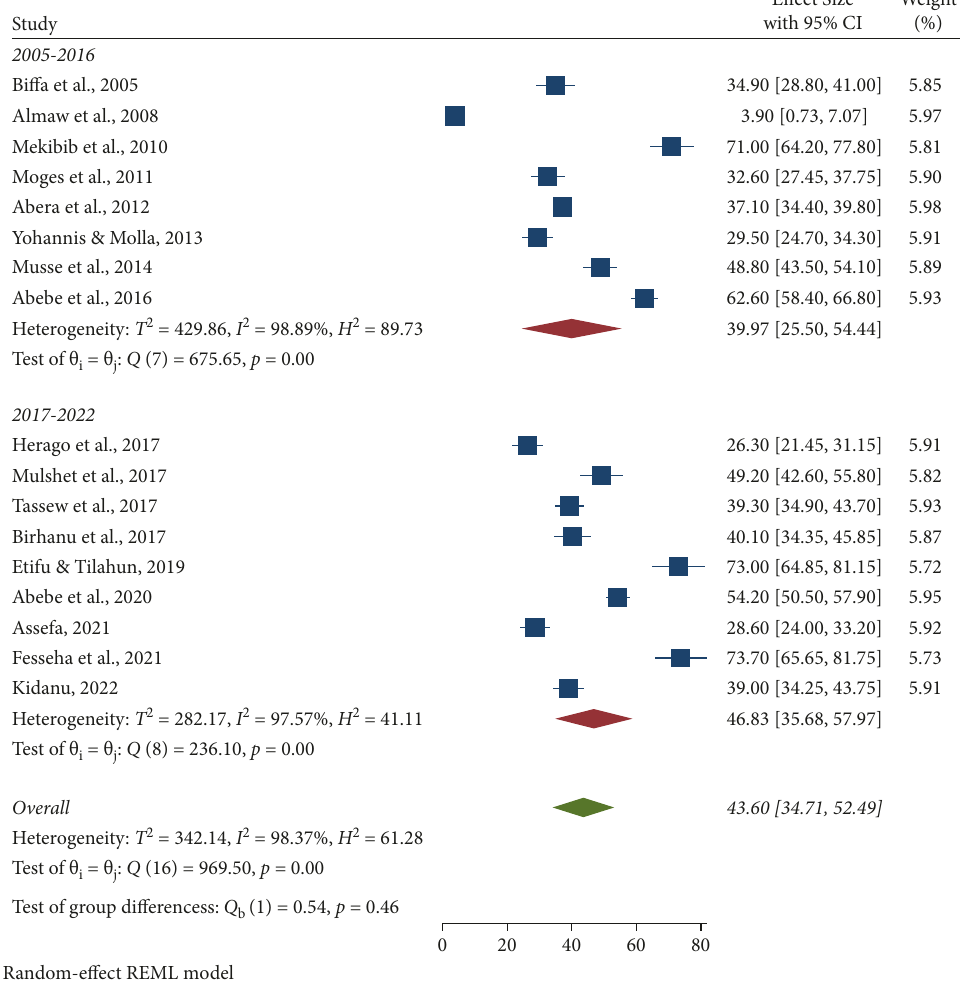
Figure 6: Pooled prevalence of bovine mastitis among dairy cows by